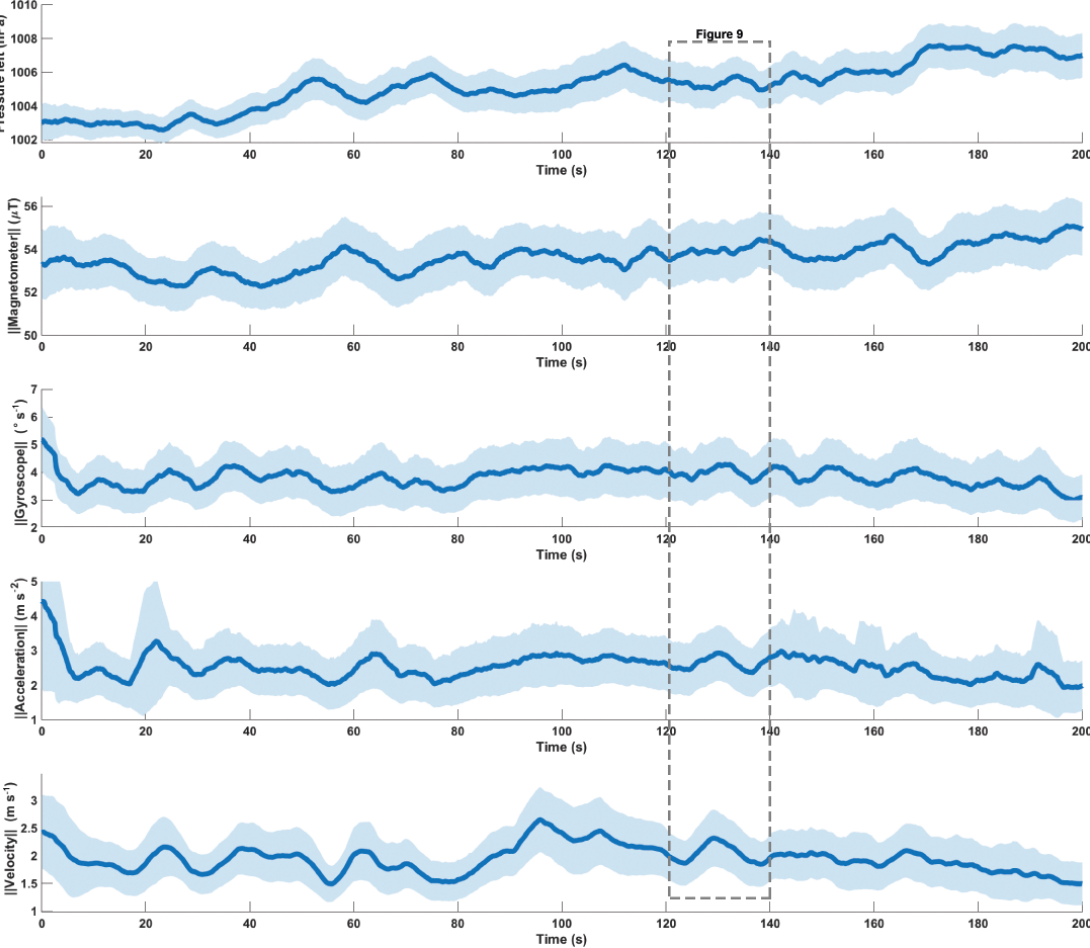
Figure 7. Left pressure overlaid with the magnitudes of the magnetometer, the gyroscope, the accelerometer and the velocities, obtained from acceleration integration. The line is the moving mean with a 5s time window, and the shaded area represents the 95% CI of 40 deployments ( n =